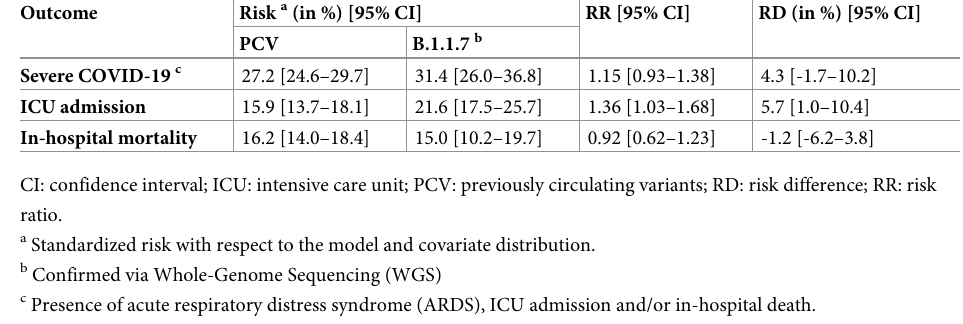
Table 2. Risk per exposure group (in %), Relative Risk (RR) and Risk Difference (RD, in %) estimates and 95% Confidence Interval (CI) for main and secondary outcomes within a multi-center matched cohort study to assess the impact of SARS-CoV-2 variants on COVID-19 disease severity among hospitalized patients in Belgium.